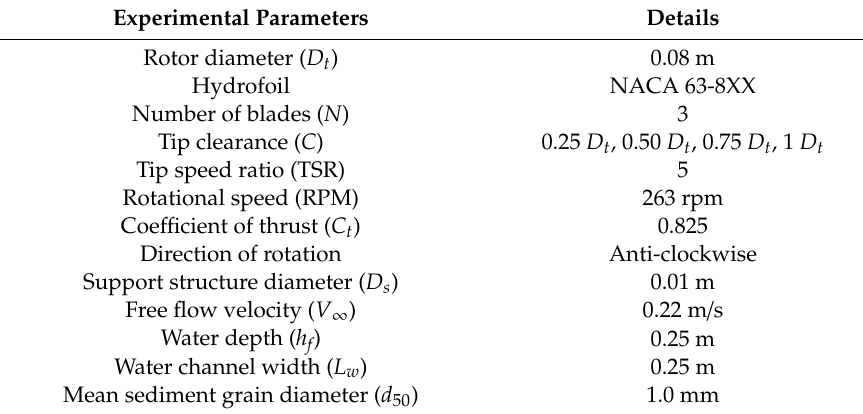
Table 3. Experimental parameters used in turbine